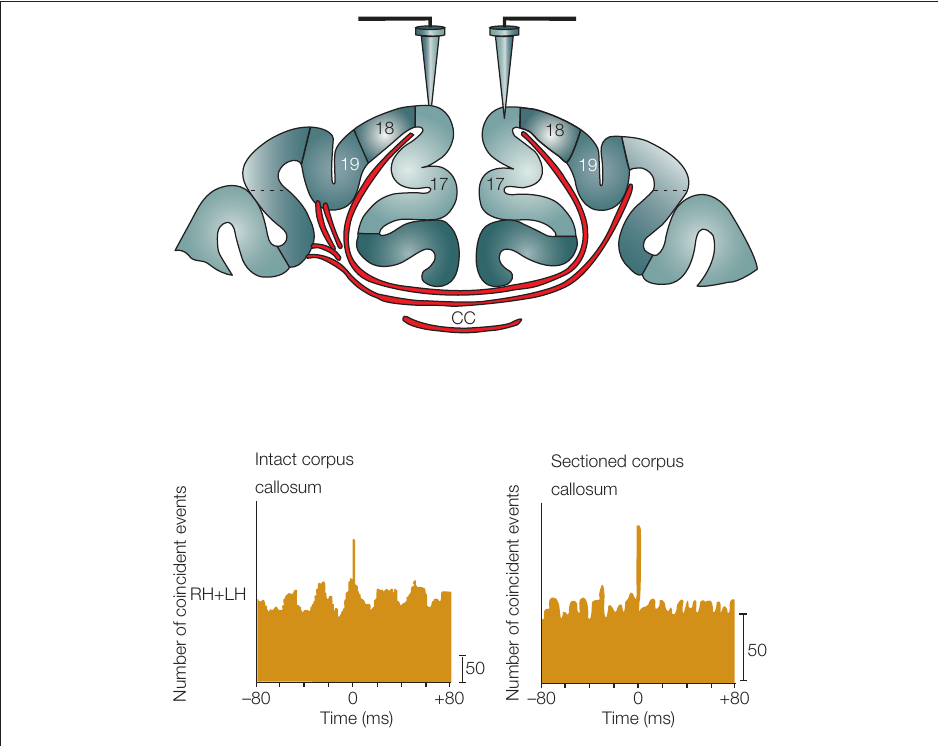
FiGure 3 | Synchrony of gamma-oscillation in cat visual cortices. Callosal connections mediate long-distance synchronization. In the bottom panels are cross-correlograms between responses from different recording sites in the left hemisphere (LH) and right hemisphere (RH) that indicate the degree of interhemispheric synchronization. When the corpus callosum was intact (left-hand panel), strong interhemispheric synchronization occurred with no phase lag between the LH and RH recording sites. Sectioning of the corpus callosum (right-hand panel) abolished interhemispheric synchronization while leaving synchronization within hemispheres intact. Adapted from Uhlhaas and Singer